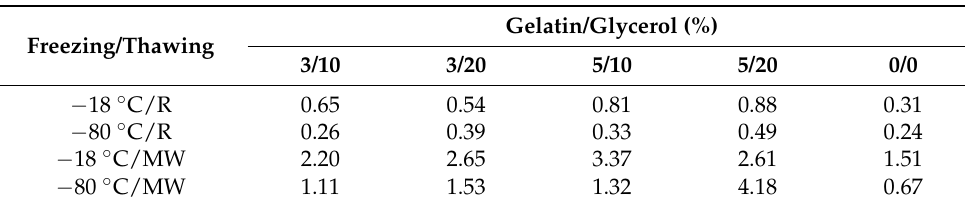
Table 9. Weight loss (%) of meat after thawing with and without coating depending on the method of freezing and thawing.